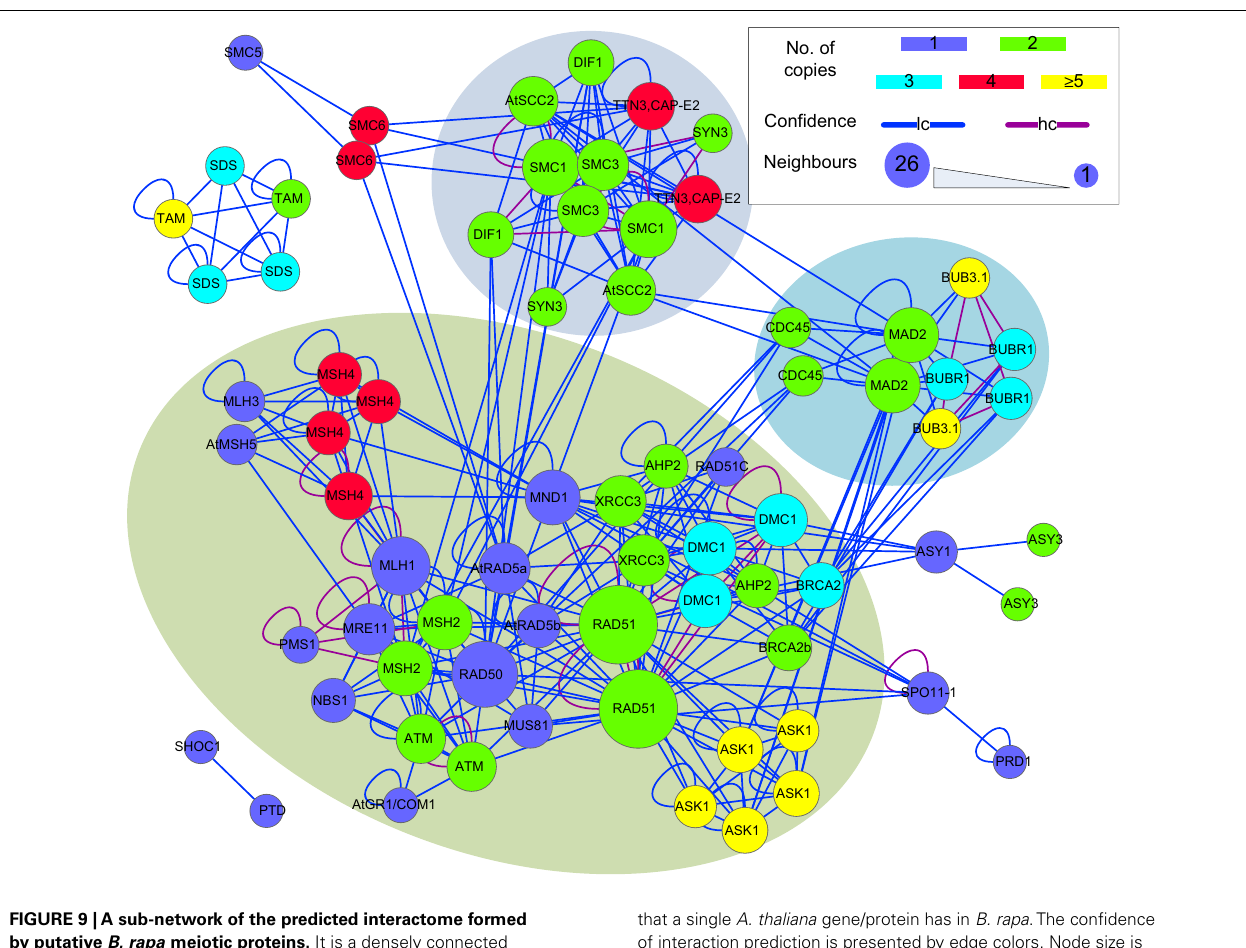
FIGURE 9 |A sub-network of the predicted interactome formed by putative B. rapa meiotic proteins. It is a densely connected network containing several hub proteins. B. rapa proteins are shown by their A. thaliana counterparts’ names; their unique accession numbers are not shown. Node color denotes the number of copies